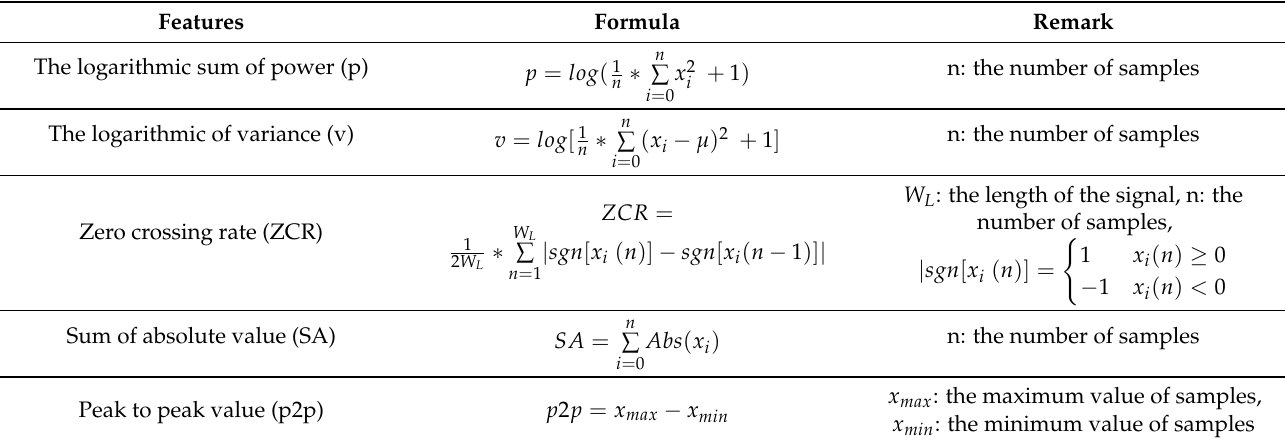
Table 1. Overview of the extracted